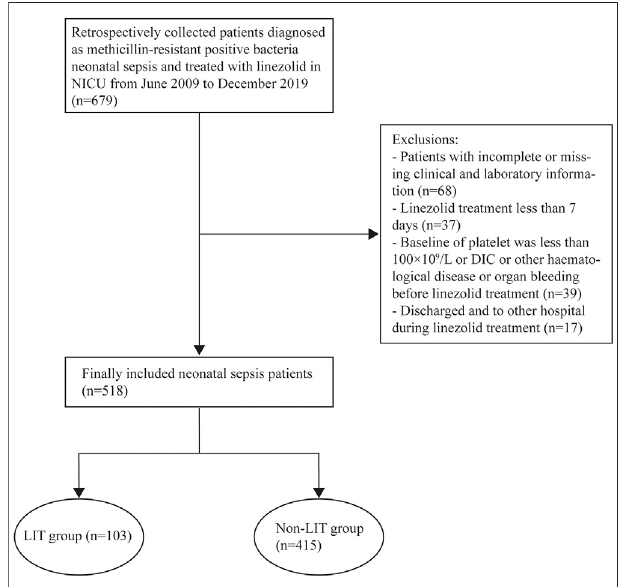
FIGURE 1 | Flowcharts of patients included and excluded from the study. LIT, LZD-induced thrombocytopenia; Non-LIT, non-LZD-induced